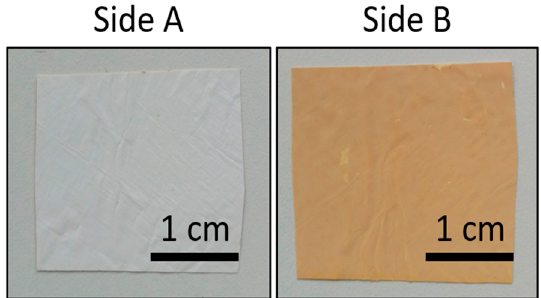
Figure 3. Photographs of the PVA-CNP Janus membrane. Side A: uncovered. Side B: coated with plasma polymerized CNPs.